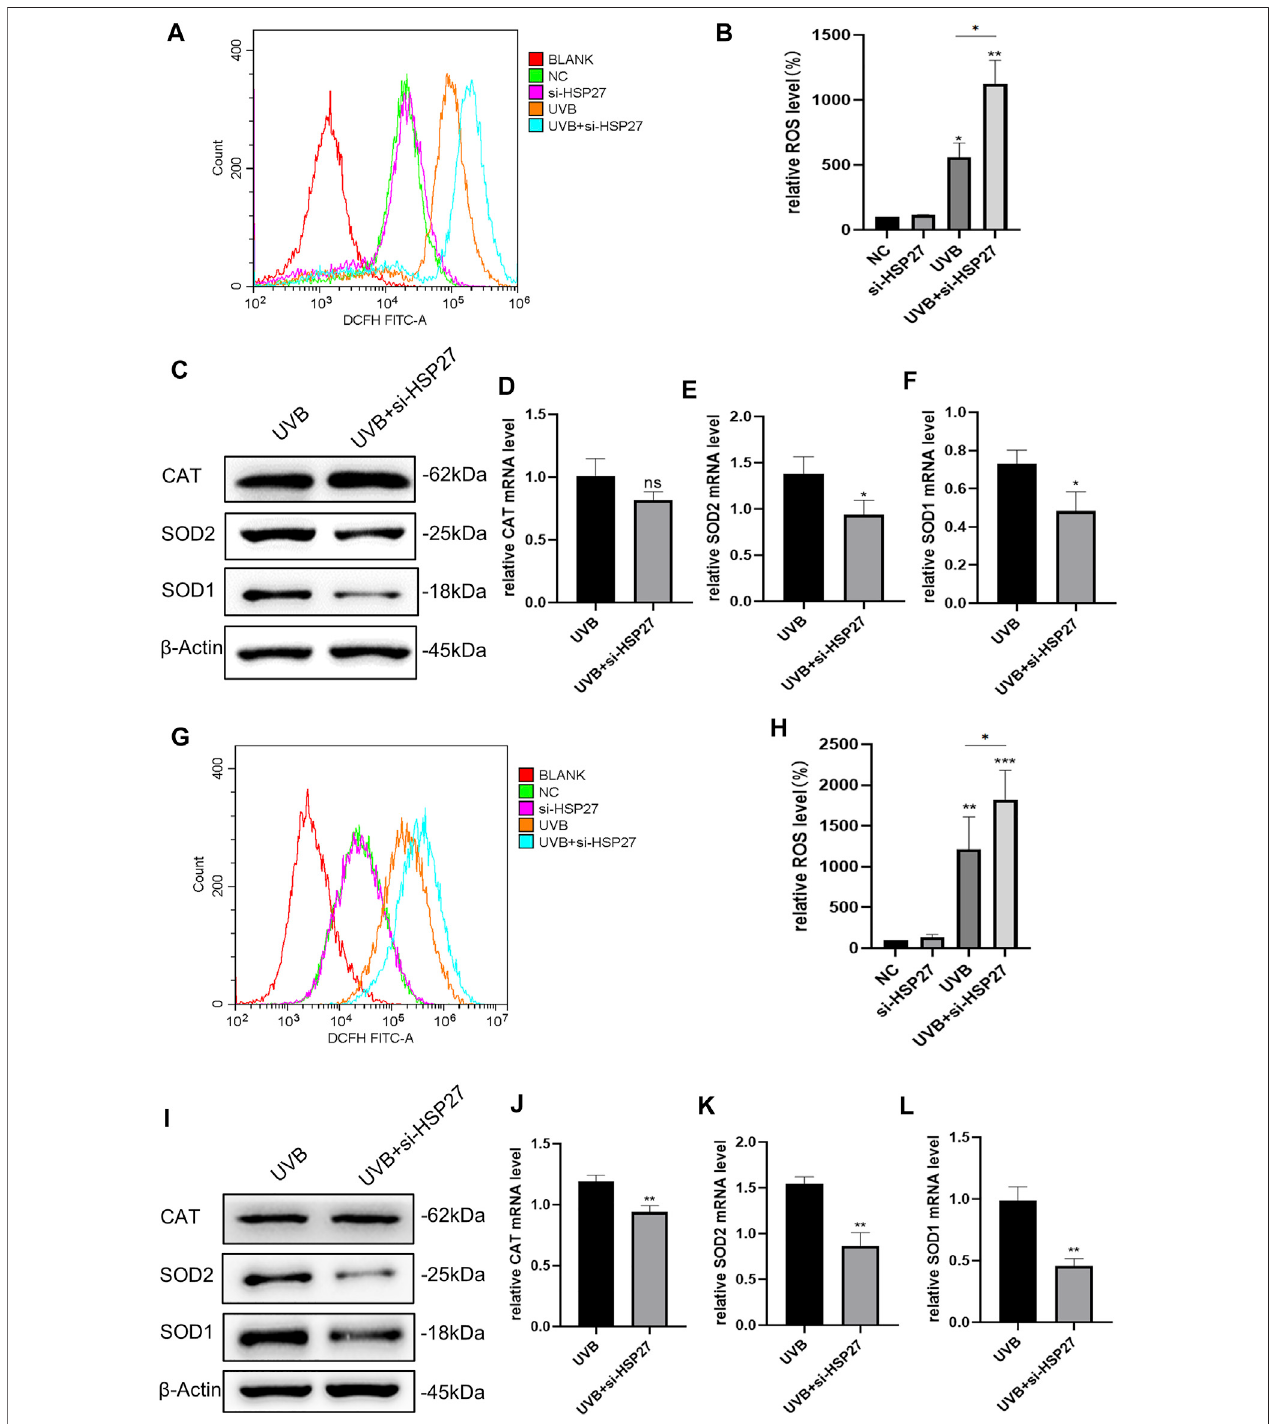
FIGURE 3 | Effect of HSP27 knockdown on the antioxidant capacity of cells irradiated with UVB. (A,B) Alterations of ROS level in HEKs after HSP27 gene knockdown. (G,H) Alterations of ROS level in HDFs after HSP27 gene knockdown. (C) CAT, SOD1 and SOD2 protein expressions were detected by using Western blottinginHEKsafterHSP27geneknockdown,regarding β -actinasareference. (I) CAT,SOD1andSOD2proteinexpressionsweredetectedbyusingWesternblotting in HDFs after HSP27 gene knockdown, regarding β -actin as a reference. (D – F) CAT, SOD1, SOD2 mRNA levels were detected by using RT-qPCR in HEKs after HSP27 geneknockdown,quanti fi edbyusingACTB asareference. (J – L) CAT,SOD1, SOD2mRNAlevelsweredetectedbyusingRT-qPCRinHDFs afterHSP27 gene knockdown, quanti fi edbyusing ACTB asareference.All theresults wereexpressed asmean± SD,and the experiment wasrepeatedfor at leastthree times (* p < 0.05, ** p < 0.01, *** p < 0.005).